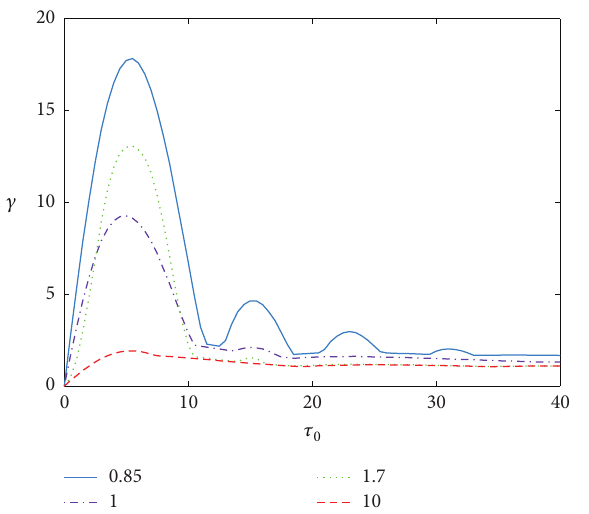
Figure 6: The effect of the angle of the tilted support spring on the two-dimensional shock response spectrum of critical components, where 𝛽 ̈𝑢 0𝑚 = 0.1 , 𝜆 1 = 0.85 , and 𝜆 2 = 0.01